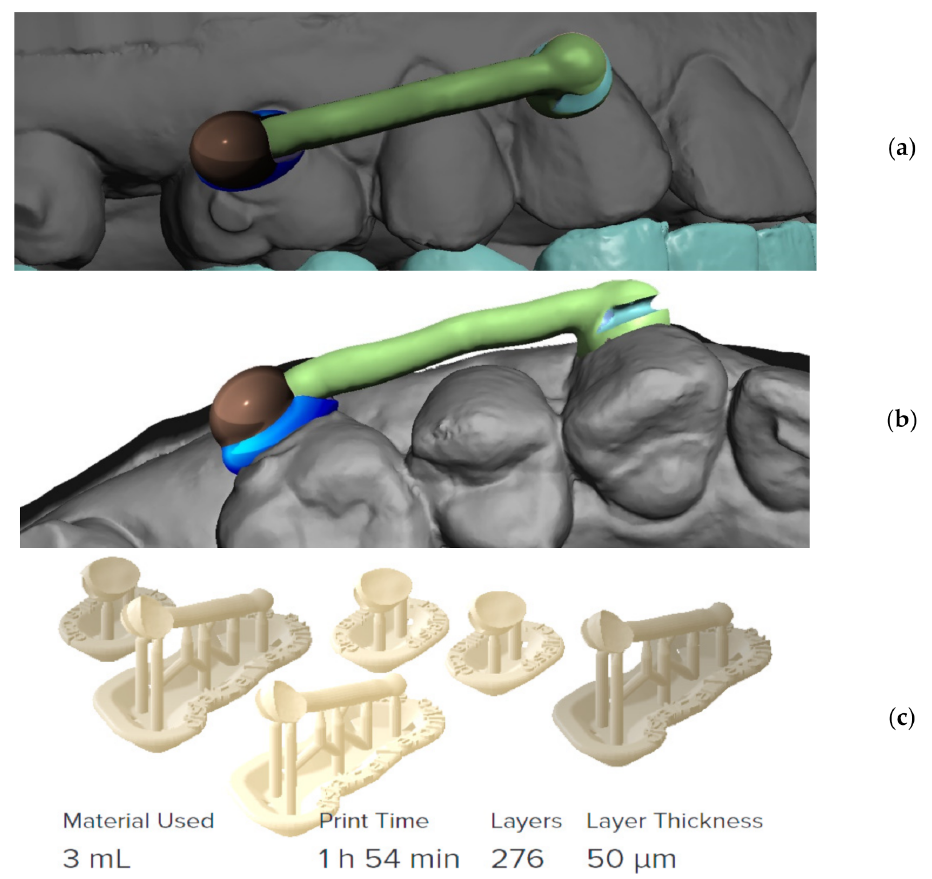
Figure 12. Final distalizer before 3D printing; ( a ) lateral view; ( b ) apical view; ( c ) 3D printing set-up for 50 µ m printing resolution with visible supports; three clones were always printed for possible servicing reasons, material Denture teeth, shade A2.